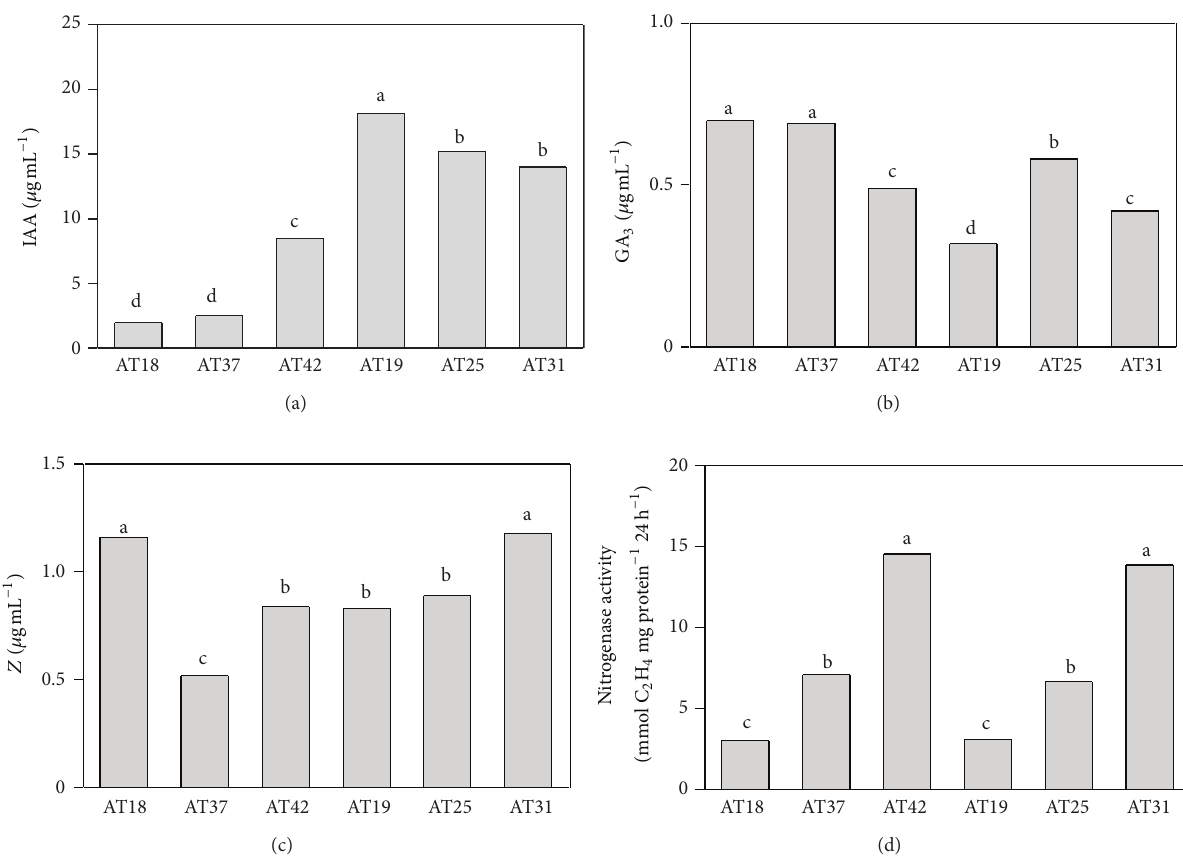
Figure 3: Phytohormone production and nitrogenase activity by the selected Azotobacter strains. (a) Indole-3-acetic acid (IAA) production; (b) gibberellic acid (GA 3 ) production; (c) zeatin (Z) production, and (d) nitrogenase activity. IAA and GA 3 were identified and quantified by gas chromatography-mass spectrometry, Z was identified and quantified by HPLC-UV, and nitrogenase activity (acetylene-ethylene reduction) was determined by gas chromatography. Bars are means of three replicates. The same letters indicate no significant differences between means as determined by the DGC test ( 𝑃 = 0.05 ).